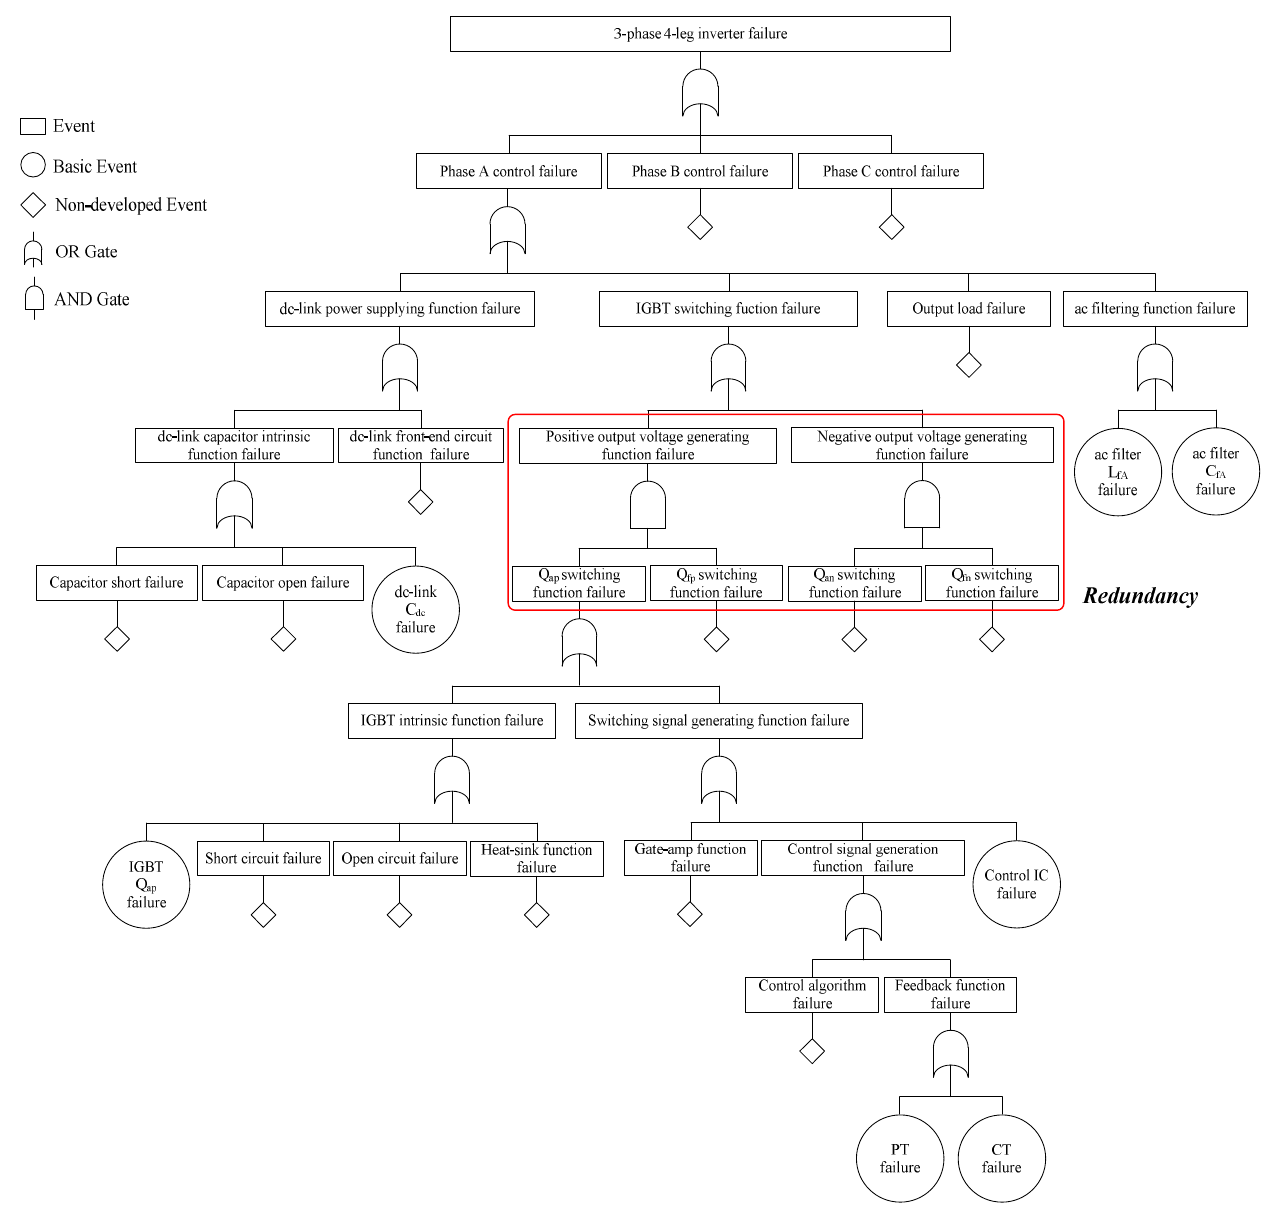
Figure 11. Fault-tree of three-phase 4-leg inverter.